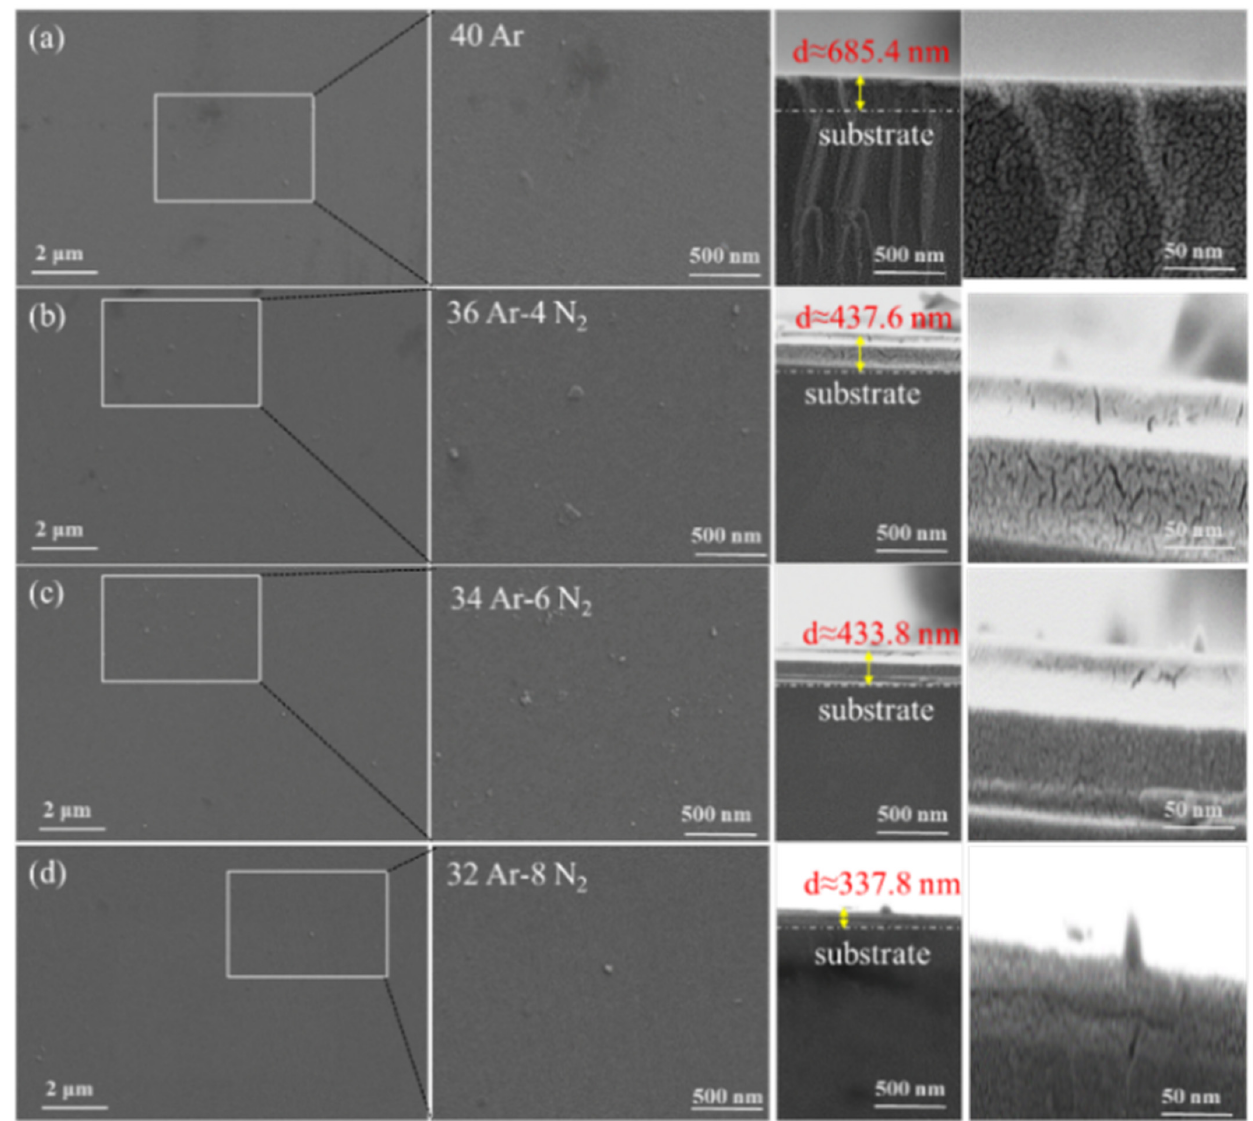
Figure 3. SEM images of surface and cross-section morphology of Ta 2 O 5 coatings prepared at a sputtering power of 140 W under different N 2 and Ar gas flow rates: ( a ) 40Ar, ( b ) 36Ar-4N 2 , ( c ) 34Ar-6N 2 , ( d ) 32Ar-8N 2 .